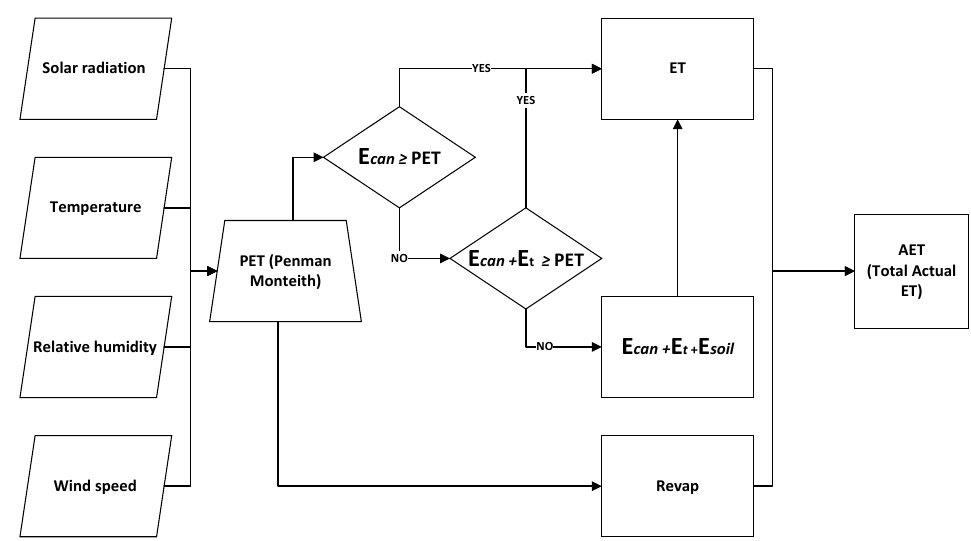
Figure 1. SWAT ET flowchart (Penman–Monteith method).